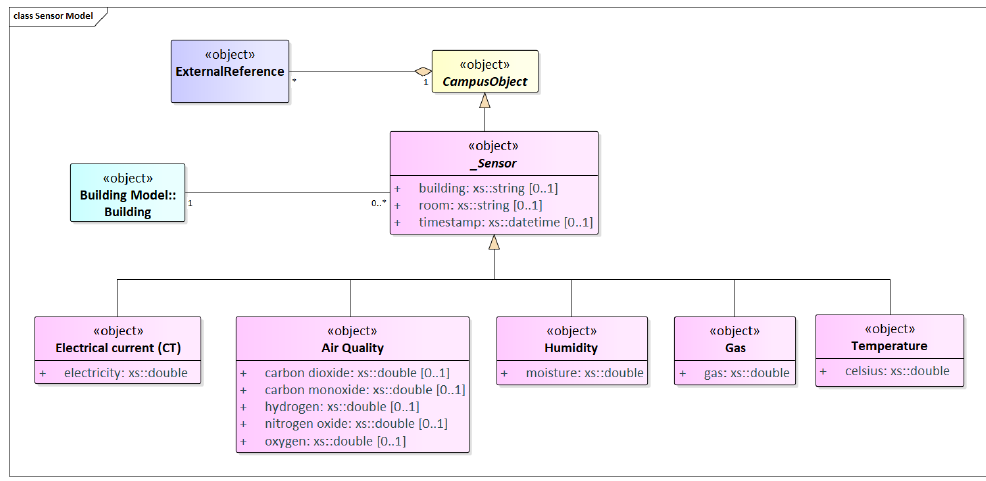
Figure 9. UML diagram of sensor model.